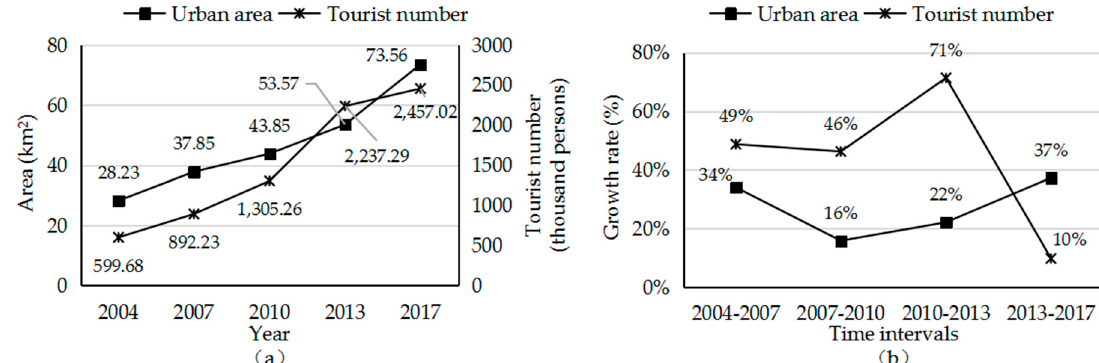
Figure 8. The comparison of the growth of urban expansion and the tourist population: ( a ) the comparison of the urban area and tourist population; ( b ) the comparison of the growth rates of urban areas and the tourist population.